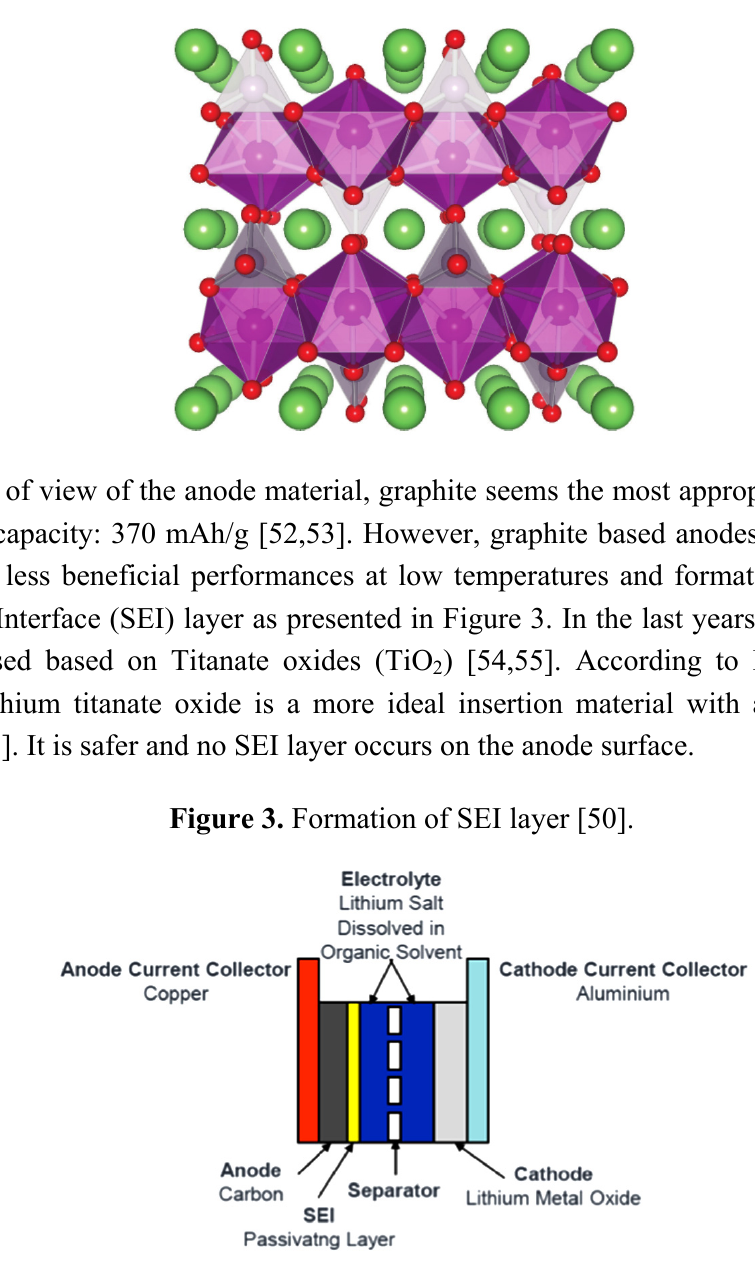
Figure 2. Olivine structure [51].